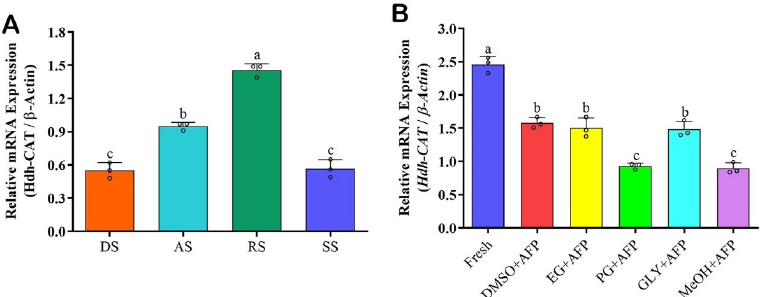
Figure 7. Hdh-CAT mRNA expression levels at different testicular developmental stages and in cryopreserved sperm samples of Pacific abalone. ( A ) Hdh-CAT mRNA expression level in different testicular developmental stages. ( B ) Hdh-CAT mRNA expression levels at cryopreserved sperm samples. DS, degenerative stage; AS, active stage; RS, ripening stage; SS, spent stage; DMSO + AFP, 8% dimethyl sulfoxide + antifreeze protein; EG + AFP, 8% ethylene glycol + antifreeze protein; PG + AFP, 6% propylene glycol + antifreeze protein; GLY + AFP, 2% glycerol + antifreeze protein; and MeOH + AFP, 2% methanol + antifreeze protein. Different letters above the bars indicate significant differences ( p < 0.05).